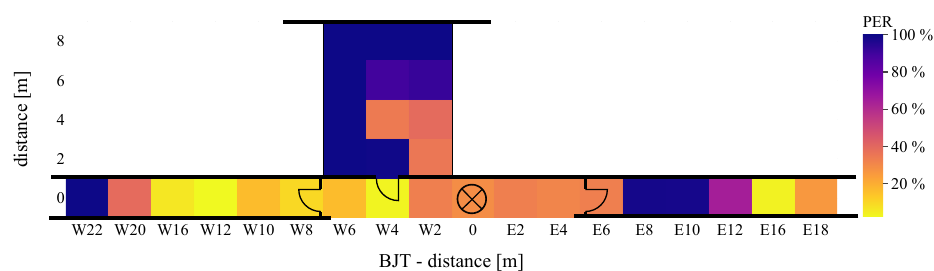
Figure 23. Packet error rate of BJT board with WuRx and WuTx on different floors.